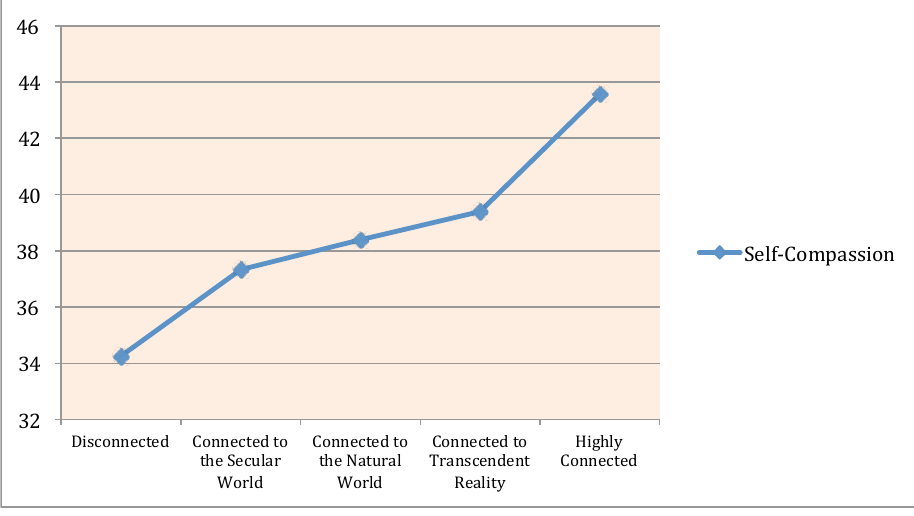
Figure 8. One-way ANOVA of mean self-compassion across five classes of spiritual connection, F =20.04*. * p < .01.